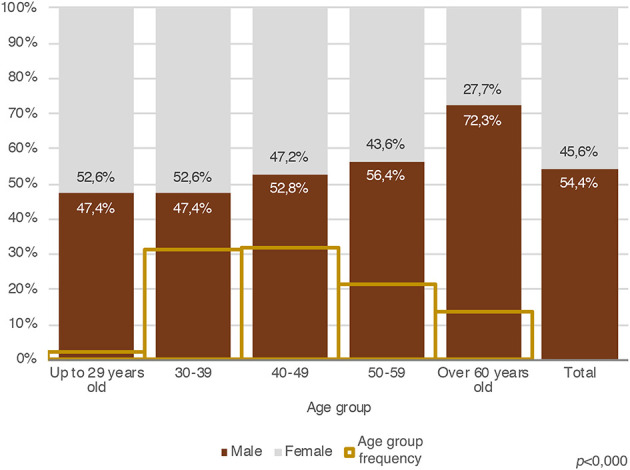
Gender distribution by age group and incidence of total age group (Source: our survey).